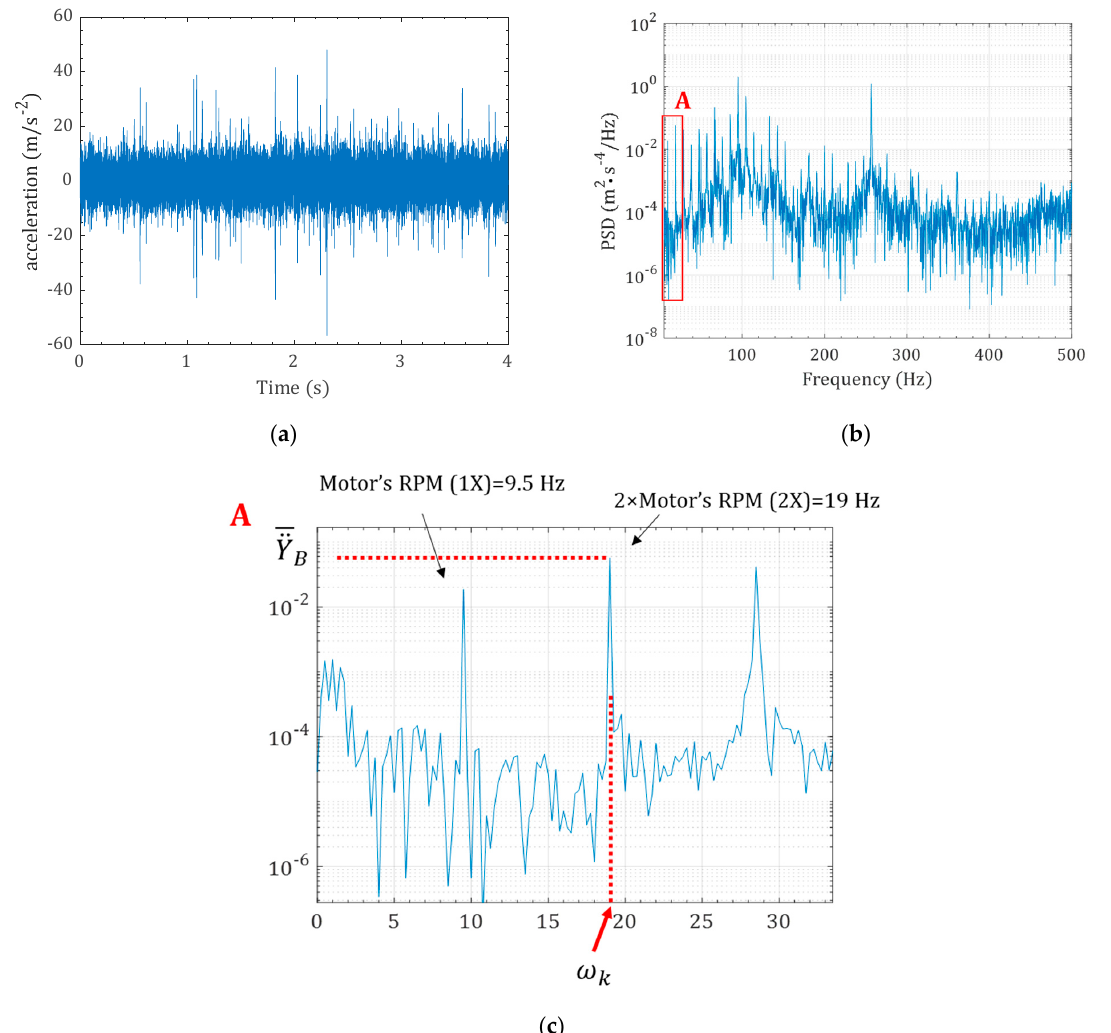
.. a B ( ω ) and ( b ) the Φ B ( ω ) , and